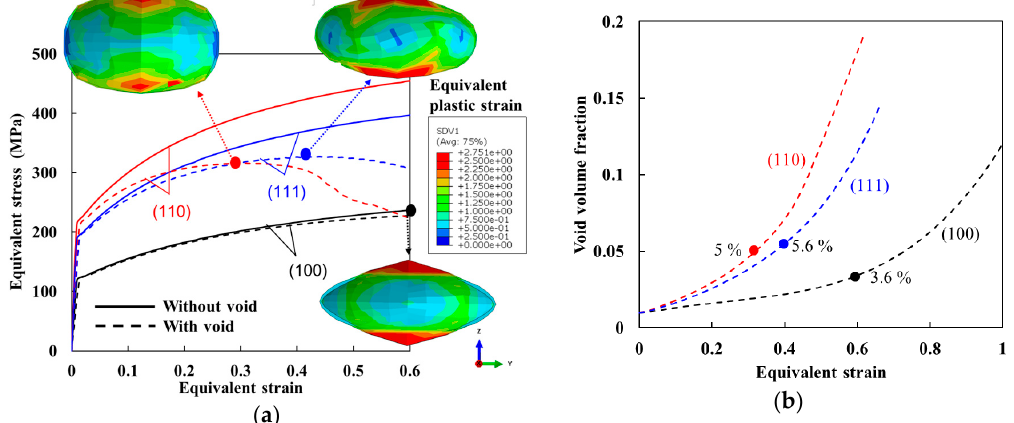
Figure 4. ( a ) stress–strain curves of RVEs with a void in a single crystal with different crystal orientations. The figure indicates the deformed voids in which the color code represents the equivalent plastic strain at one-layer elements surrounding void under a constant stress triaxiality of 1; ( b ) evolution of void volume fraction (or void growth rate) as a function of macroscopic RVE equivalent strain with different crystal orientations under a constant stress triaxiality of 1.